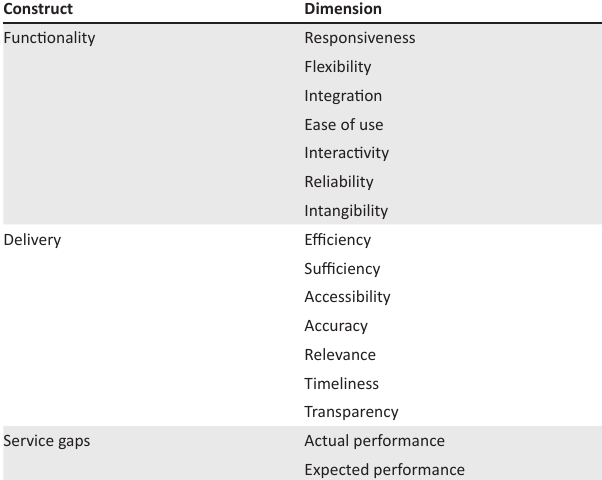
TABLE 3: The taxonomy for organising constructs and dimensions. Construct